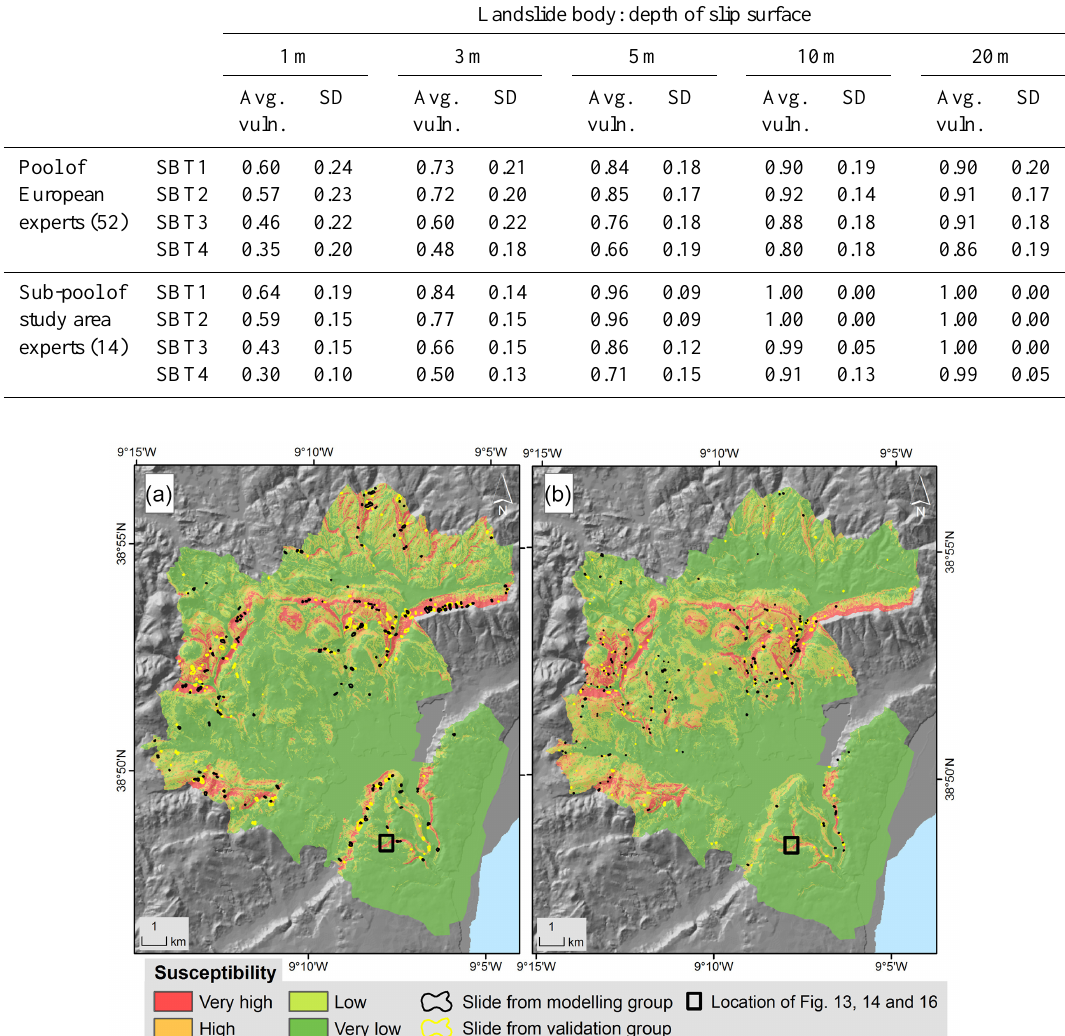
Figure 6. Landslide susceptibility maps in the Loures municipality for (a) deep-seated slides, (b) shallow slides (based on the work done by Guillard and Zêzere,